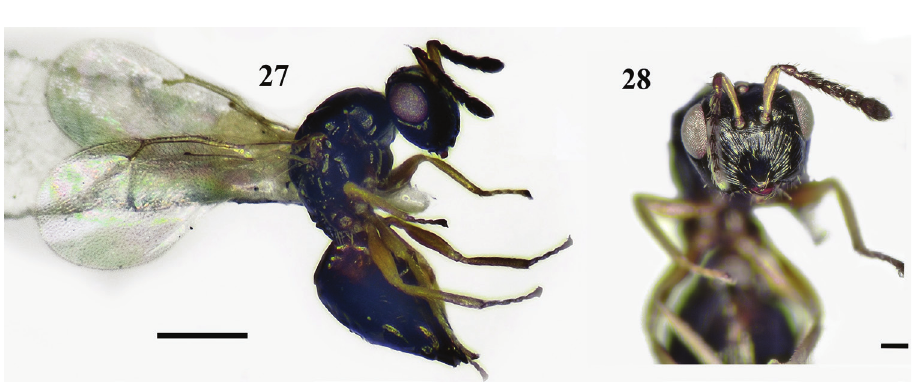
Figures 27, 28. Ceratoneura indi Girault, female 27 habitus, lateral view. Scale bar: 500 μm 28 head, frontal view. Scale bar: 100